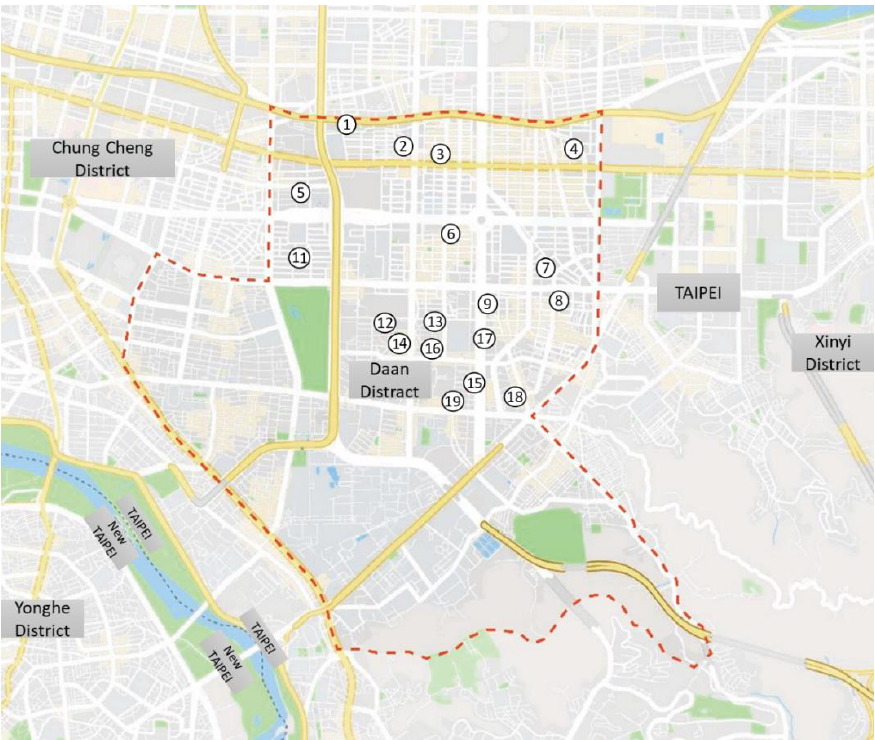
Figure 1. Selected neighborhood park locations (Number 1 – 19 referred to the parks in Table 1).